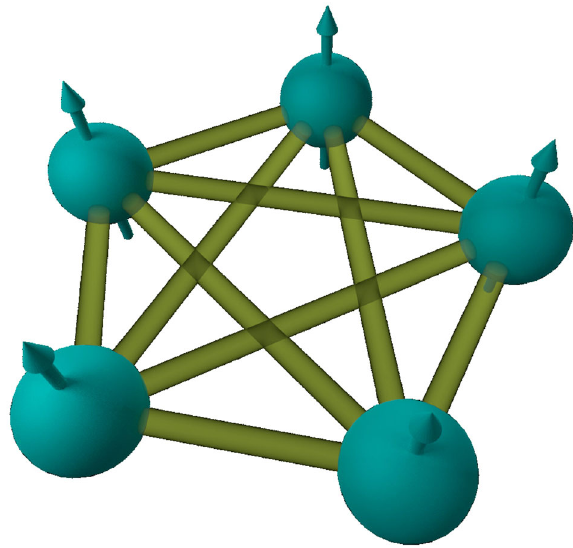
Fig. 3 Five qubit random Ising model with commuting X ⊗ X interactions with random strengths is an example of a problem within the class IQP. Qubits are prepared and measured in the computational